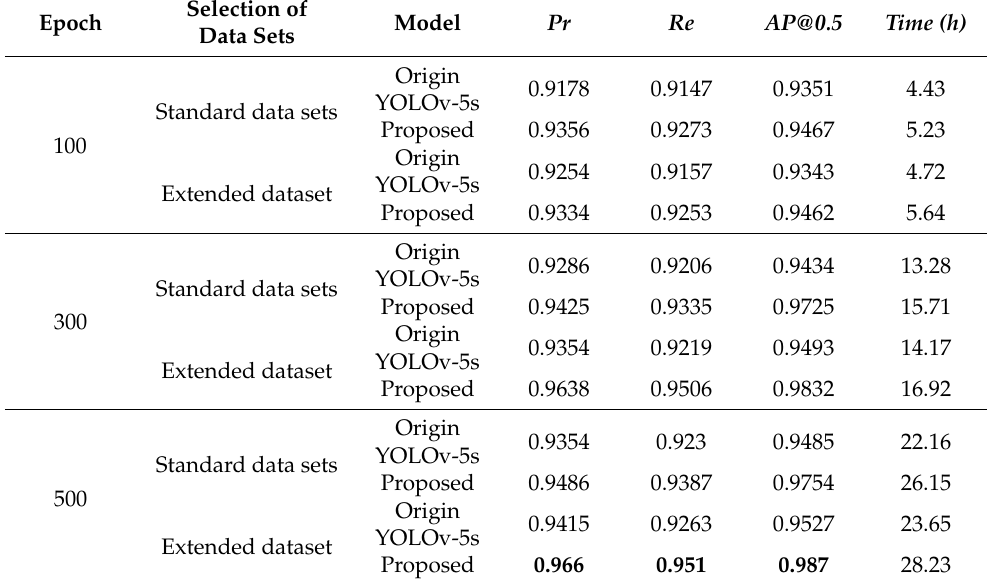
Table 2. Comparison of metrics before and after expanding the